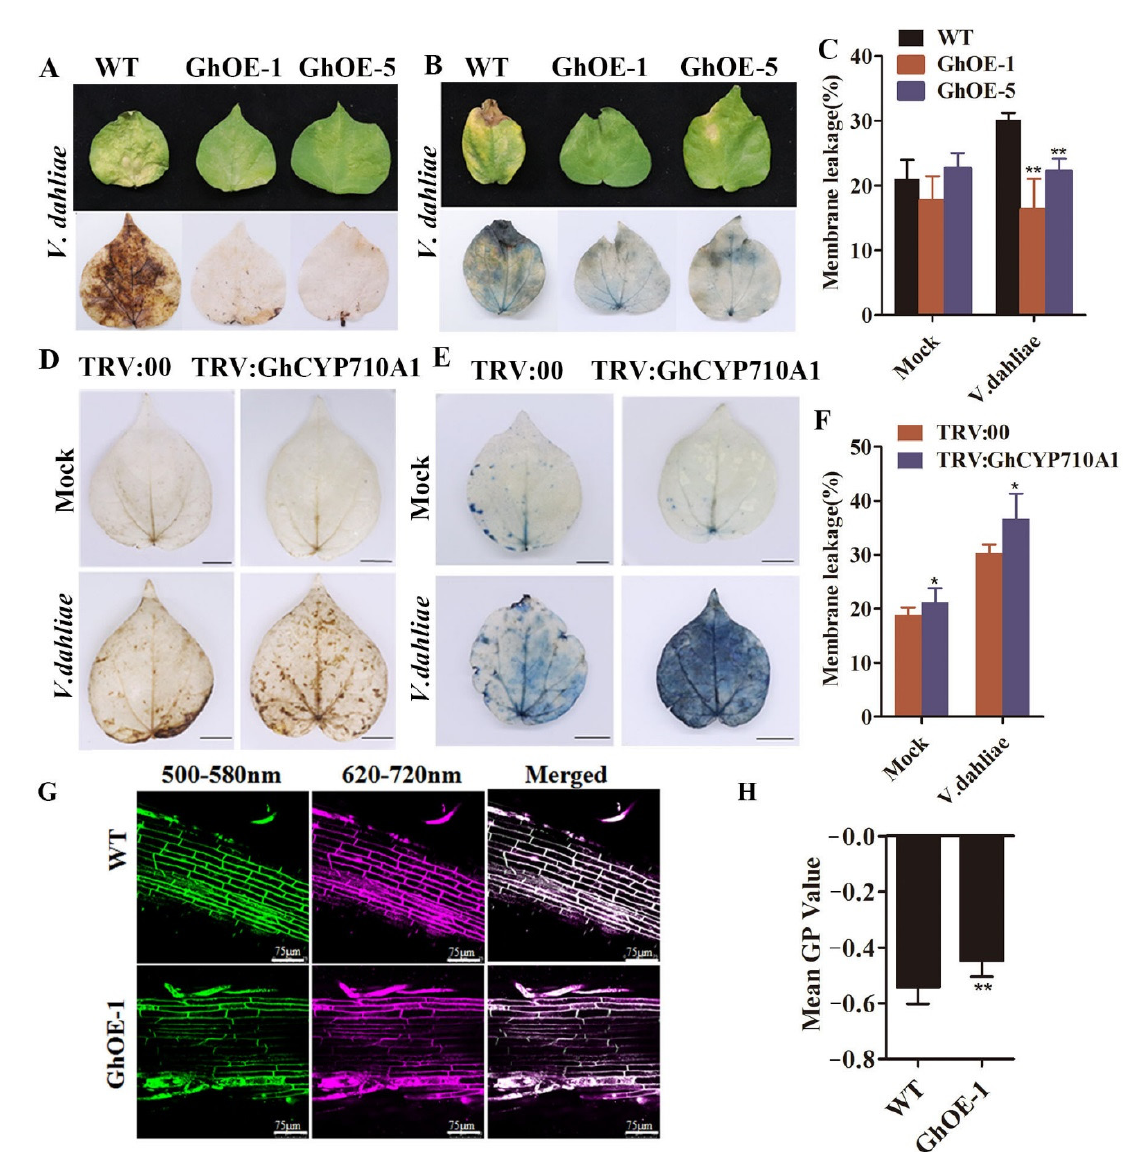
Figure 8. Overexpression of GhCYP710A1 inhibits ROS accumulation and cell membrane damage in cotton. Silencing of GhCYP710A1 leads to ROS accumulation and cell membrane damage in cotton. ( A ) DAB staining of wild-type and transgenic cotton leaves after Verticillium dahliae infection for 15 days. The brown material reflects the hydrogen peroxide content. WT: wild-type cotton; GhOE-1 and GhOE-5: GhCYP710A1 -overexpression transgenic cotton lines. ( B ) Trypan blue staining for the Verticillium dahliae infection of wild-type and GhCYP710A1 -overexpression transgenic cotton. ( C ) Electrolyte leakage in the leaves of wild-type and GhCYP710A1 -overexpression transgenic cotton. ** represents p < 0.01. ( D ) The accumulation of ROS in TRV:00 and TRV:GhCYP710A1 plant leaves by DAB staining after Verticillium dahliae infection for 15 days. ( E ) Trypan blue staining of TRV:00 and TRV:GhCYP710A1 cotton after Verticillium dahliae infection for 10 days. ( F ) Electrolyte leakage in the leaves of TRV:00 and TRV:GhCYP710A1 cotton. Scale bar = 1 cm. * represents p < 0.05. ( G ) Fluorescence imaging of di-4-ANEPPDHQ-labeled cotton root cells. WT: wild-type cotton; GhOE-1: GhCYP710A1 -overexpression transgenic cotton; 500–580 nm: the green channel; 620–720 nm: the red channel; Merged: the merged channel of green and red channels. ( H ) The GP of wild-type and transgenic cotton root cells. ** represents p <